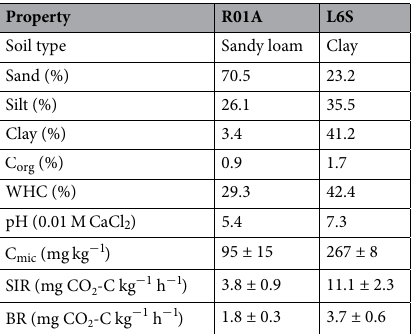
Table 1. Physicochemical and microbial (mean ± standard deviation, n=3) properties of the tested